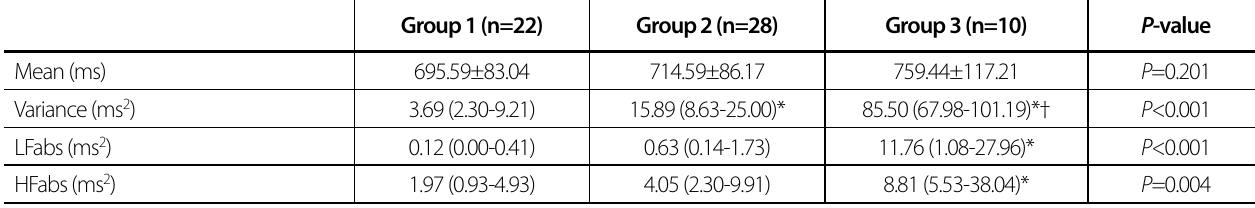
Table 2 . Linear analysis of heart rate